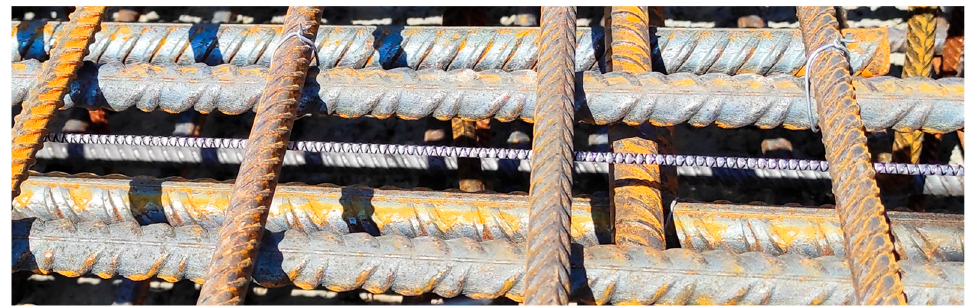
Figure 17. Installation of the monolithic sensor by tying to the existing reinforcement.